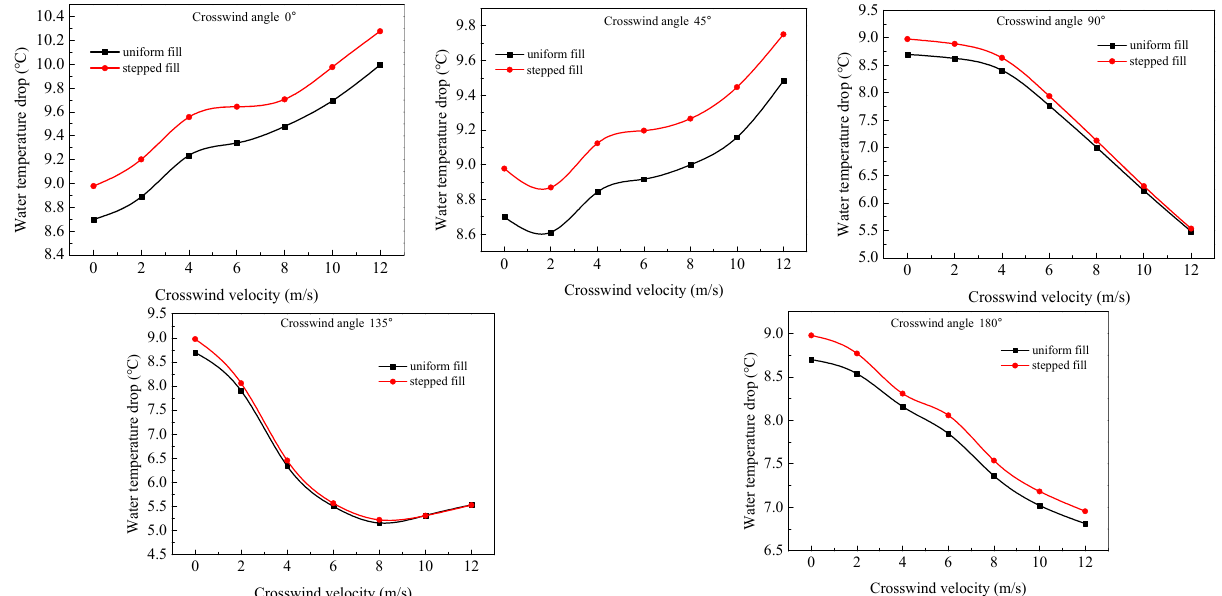
Figure 12. The changes of water temperature drop with environment wind.